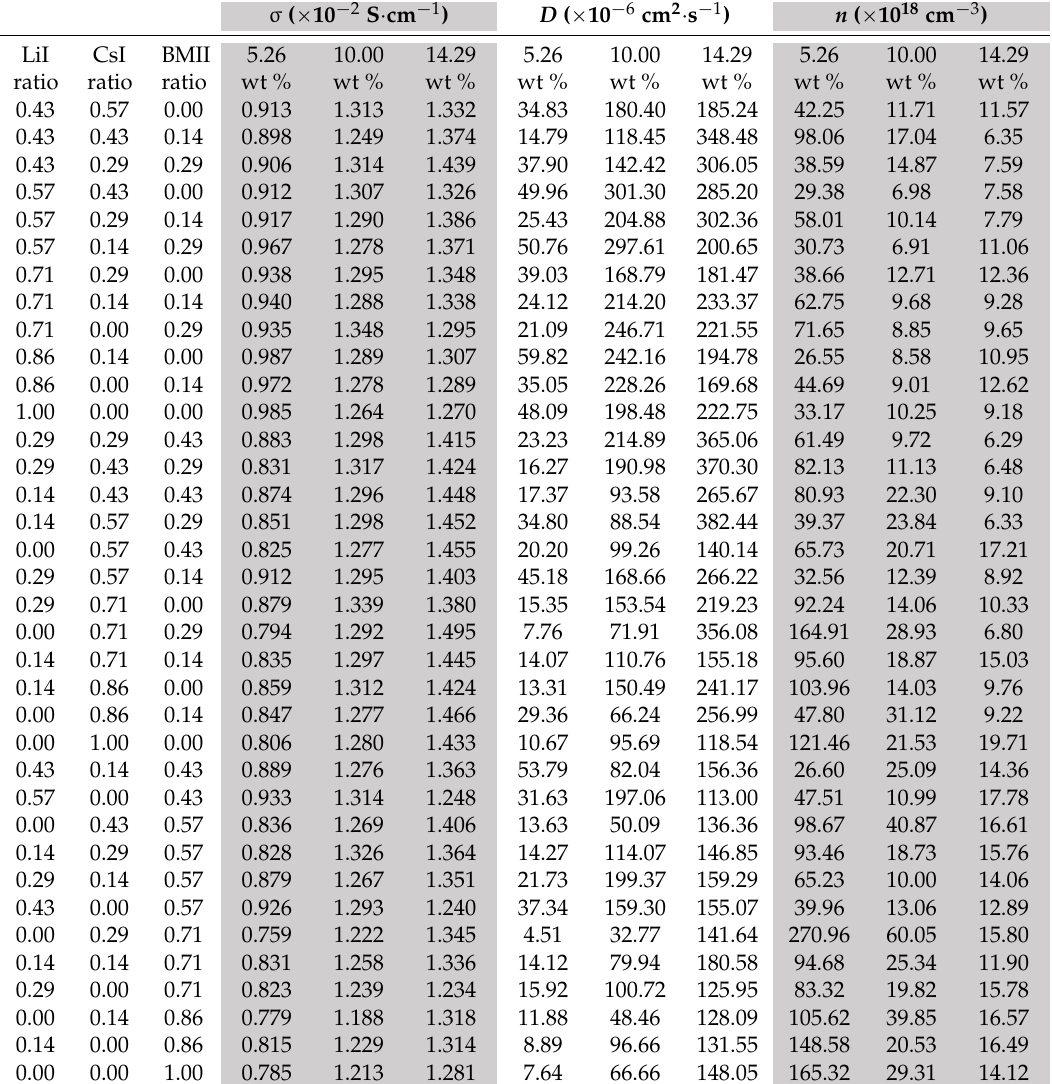
Table 1. DoE for the independent variables used in this study along with the observed